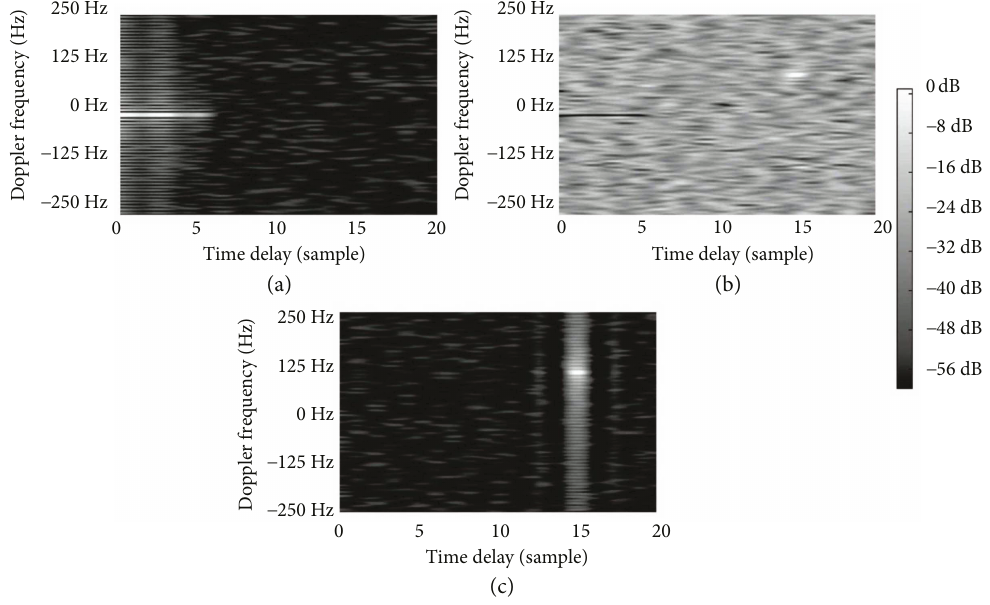
Figure 8: Calculated range-Doppler matrices with di ff erent interference cancellation schemes. The dynamic range is uniformly 60 dB